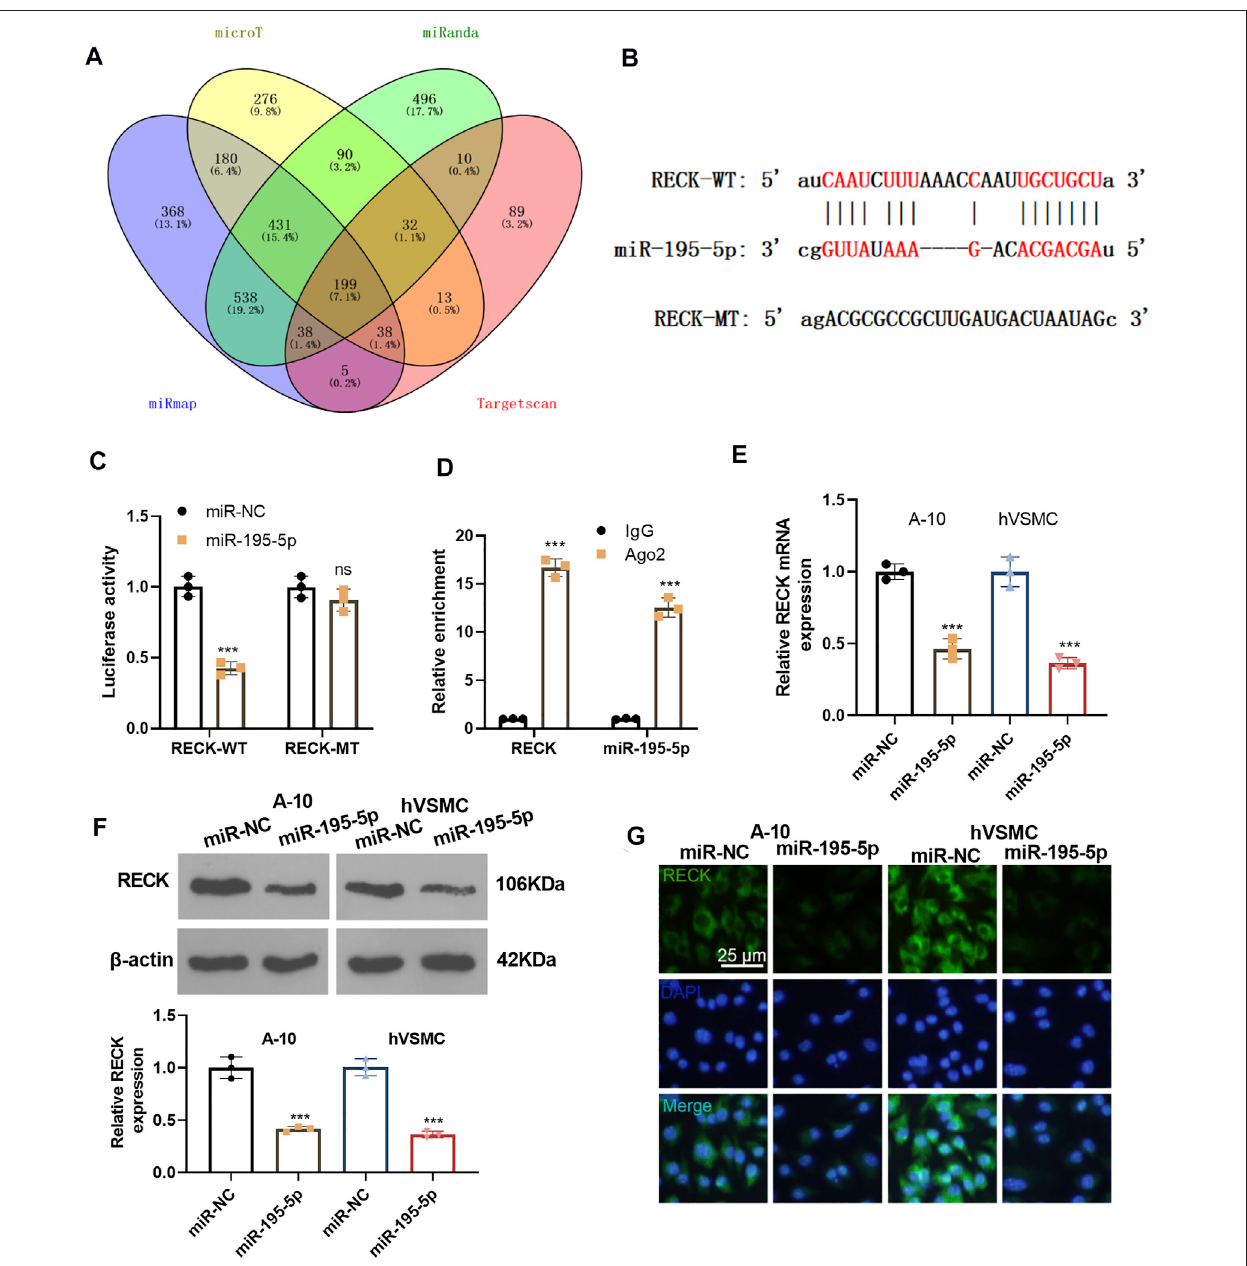
FIGURE 5 | miR-195-5p targeted RECK and inhibited its expression. (A) The downstream targets of miR-195-5p were predicted via four databases, including microT, miRanda, miRmap and Targetcan, and the potential targets of miR-195-5p were analyzed through Venn ’ s diagram. (B) The base binding relationship between RECK and miR-195-5p was shown. (C) The dual-luciferase reporter assay was adopted to con fi rm the binding relationship between MEG8 and miR-195-5p. (D) RIP veri fi ed the binding of MEG8 with miR-195-5p. NS p > 0.05, *** p < 0.001 (vs. miR-NC group). (E,F) A-10 cells or hVSMCs were transfected with miR-NC or miR-195-5p mimics. The RECK expression was tested by qRT-PCR or Western blot. *** p < 0.001 (vs. miR-NC group). (G) The RECK expression in A-10 cells or hVSMCs was gauged by immuno fl uorescence. All experiments were repeated three times, and each time was performed in